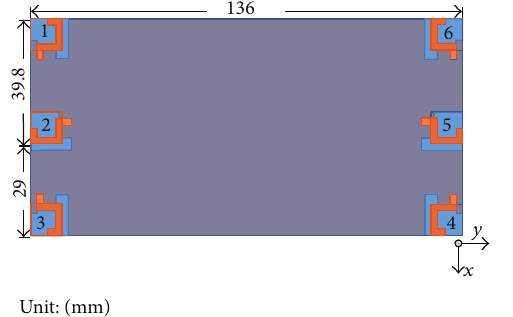
Figure 15: The structure of antennas.